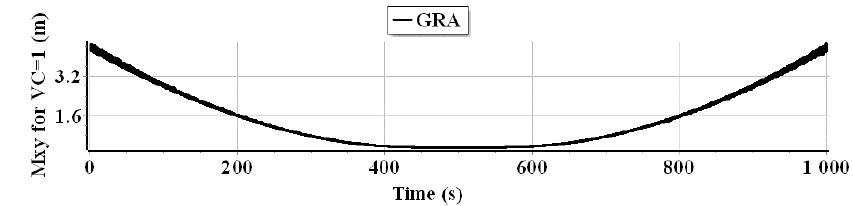
Figure 24. Graph of mean error M xy of GRA-estimated position coordinates over the course of 100 SV crossings, relative to aligned marks as a function of